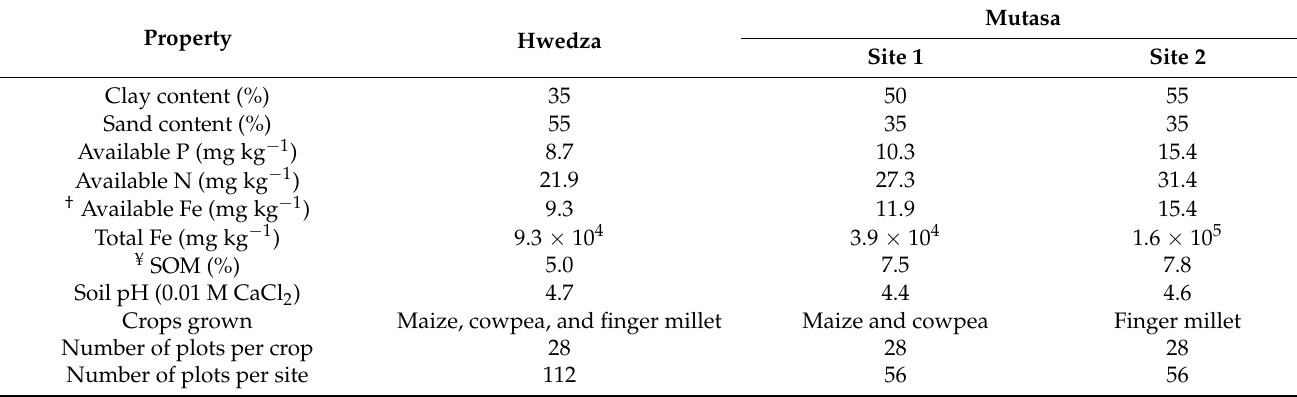
Table 1. Physiochemical properties of fields used for maize, cowpea, and finger millet experimentation, crops grown per site, and number of plots per crop type and site.